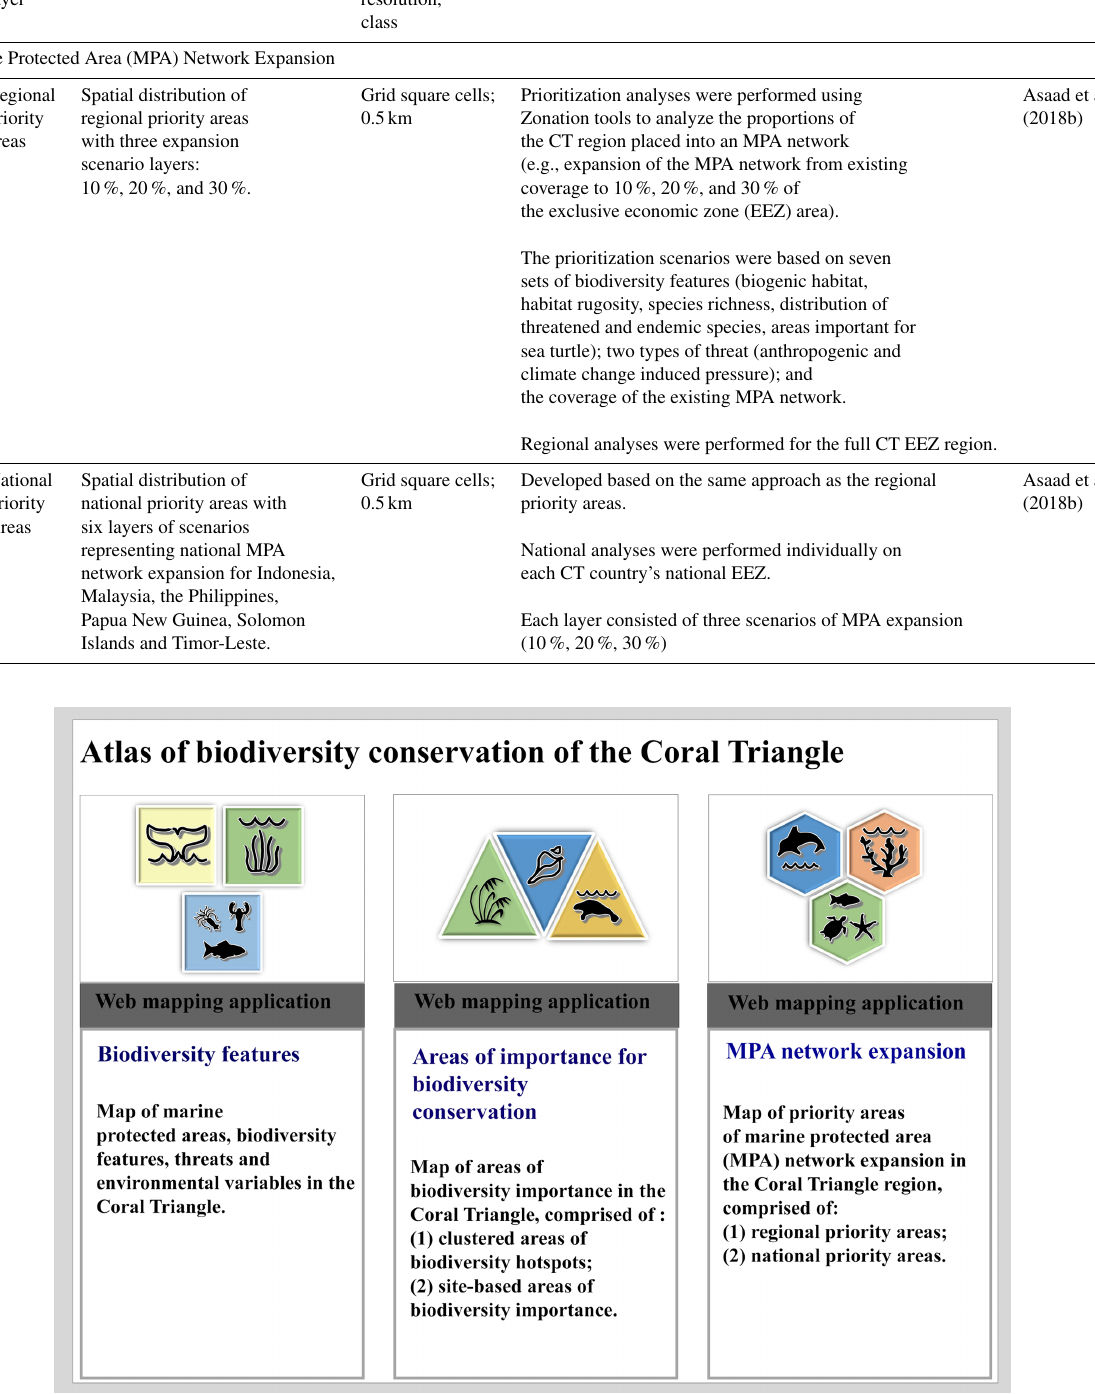
Figure 1. Coral Triangle web-mapping application front-page. This gallery-like interface provides a hyperlink to access each of the maps of the Coral Triangle